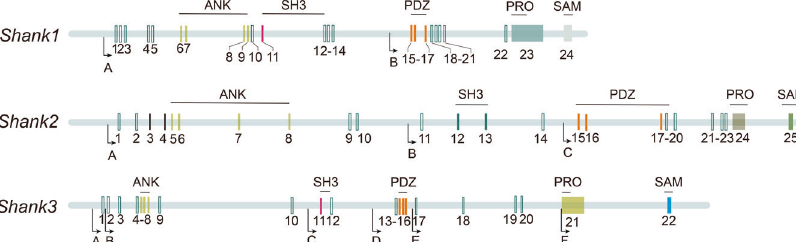
Fig. 2 Schematic diagram of SHANK genes: structure and intragenic expressed region. The schematic diagram shows the full structure of the SHANK genes and the location of intragenic promoters within these genes. The location of the protein domains is included above their respective encoding exons (in the fi gure, exons are